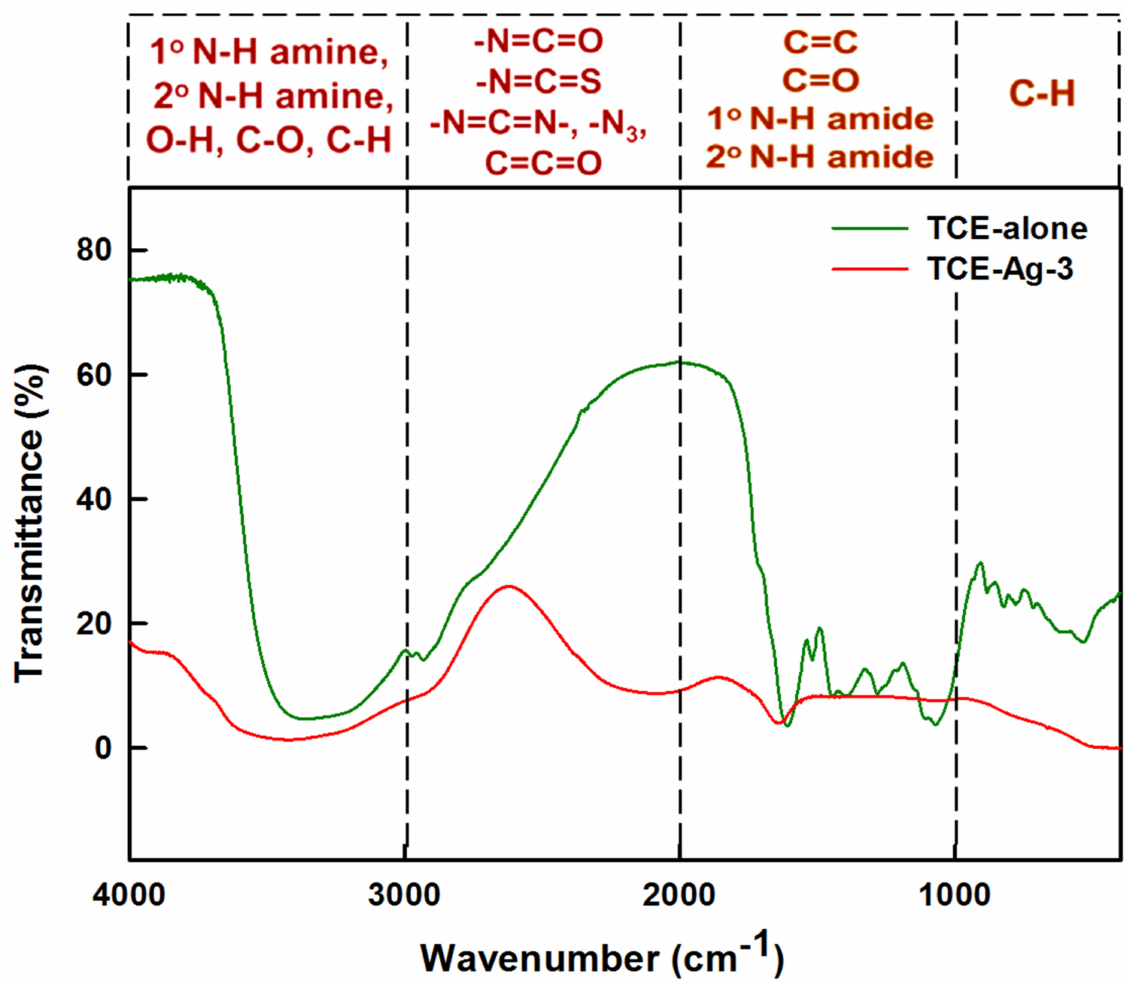
Figure 2. Comparison of FTIR spectra of TCE and TCE-capped Ag −